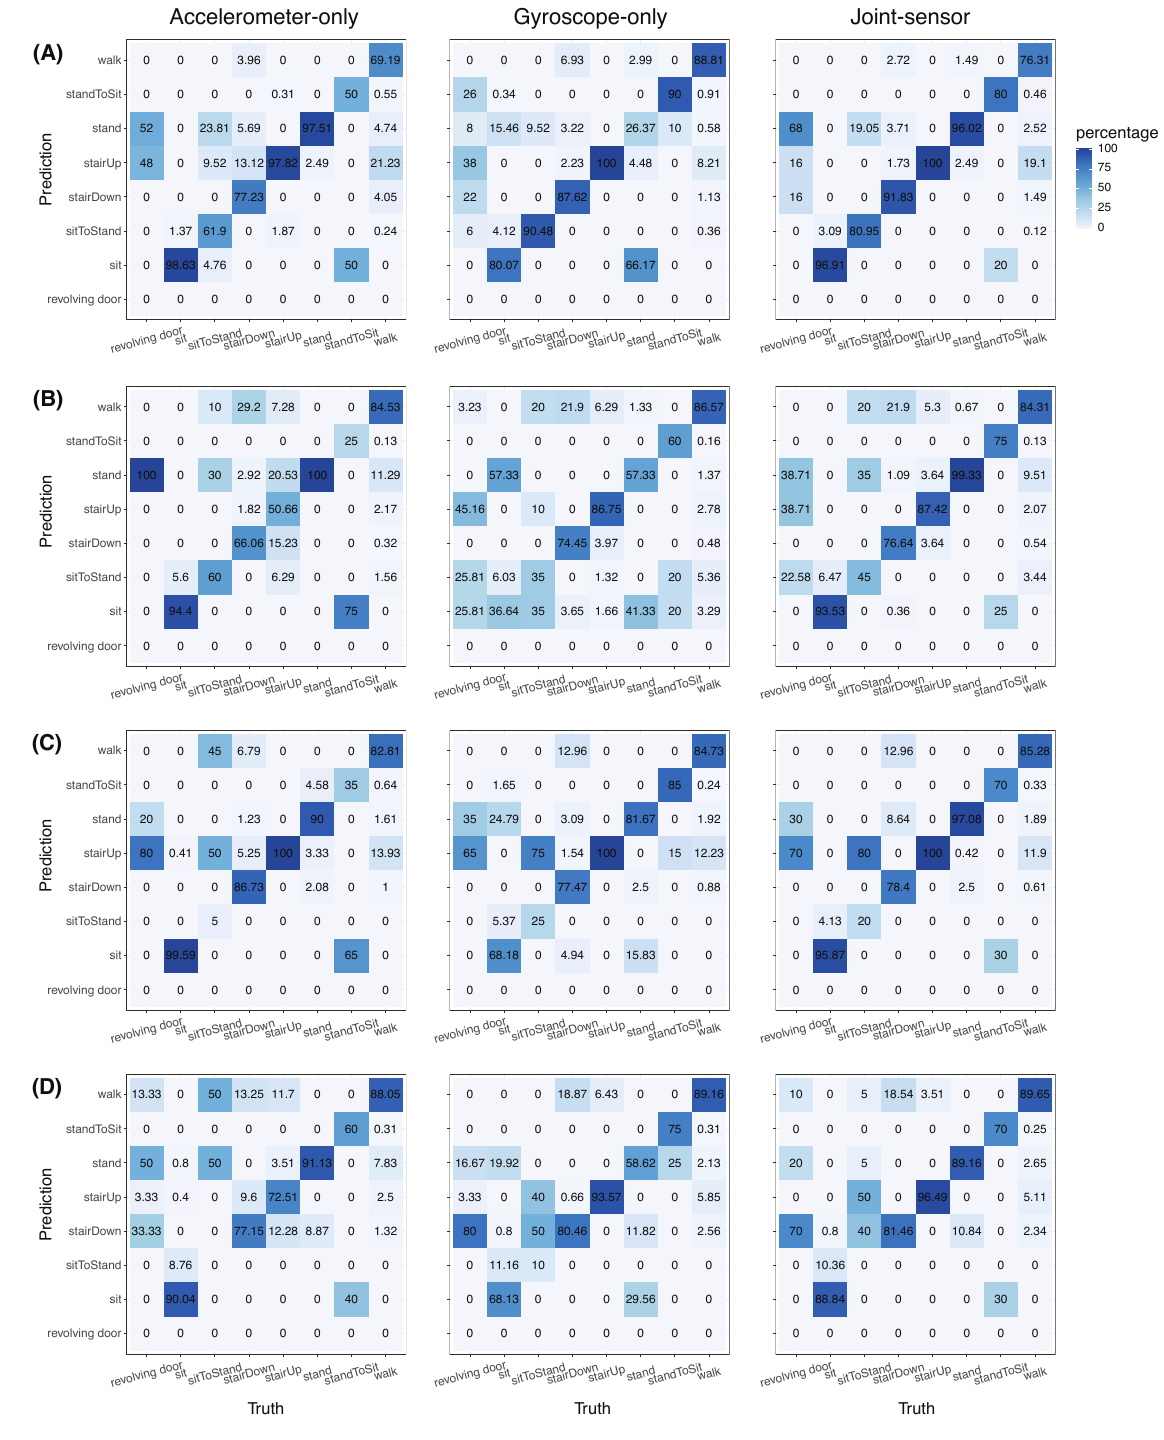
Figure 8. Confusion matrices for accelerometer-only, gyroscope-only, and joint-sensor methods. This figure presents the confusion matrices for each participant. Row ( A ) corresponds to participant 1, row ( B ) to participant 2, row ( C ) to participant 3, and row ( D ) to participant 4. For each participant, there are three confusion matrices corresponding to accelerometer-only (column 1), gyroscope-only (column 2), and joint-sensor (column 3). These confusion matrices incorporate steps 1, 2, 3, 5, and 6 in test data collection. In each confusion matrix, the ground truth activity labels are on the bottom margin, and the predicted activity labels are on the left margin. Each column shows the distribution of the predicted labels for the corresponding ground truth activity label. Thus, every column sums to